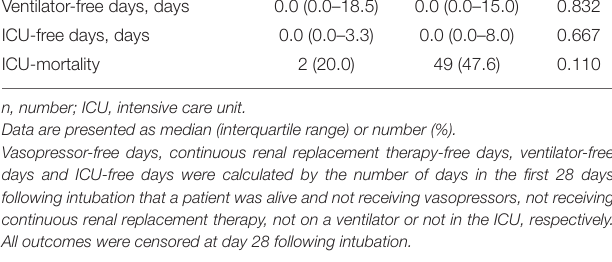
Control group group ( n = 10) ( n =